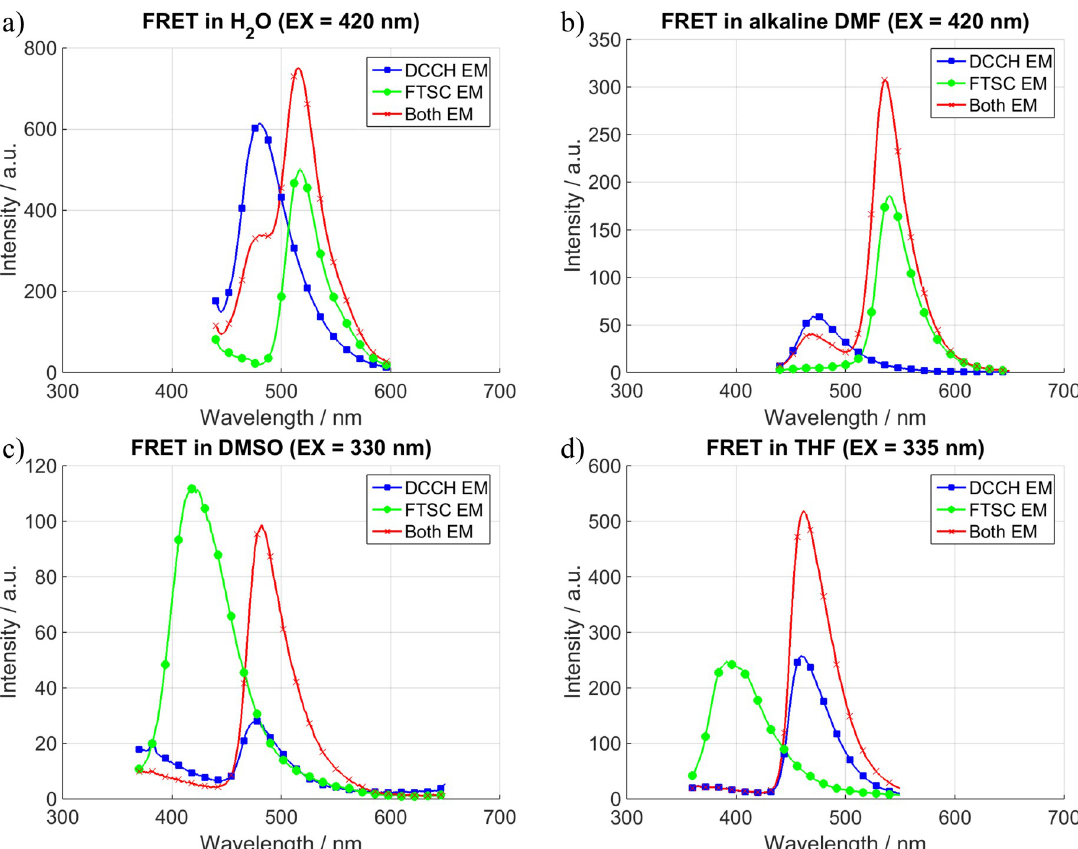
Fig 6. FRET measurements using a capillary and thus going to higher concentrations. Due to the higher concentration a FRET signal is also detected under other conditions. (Conc. H 2 O = 0.15 mM, conc. Other = 1 mM).